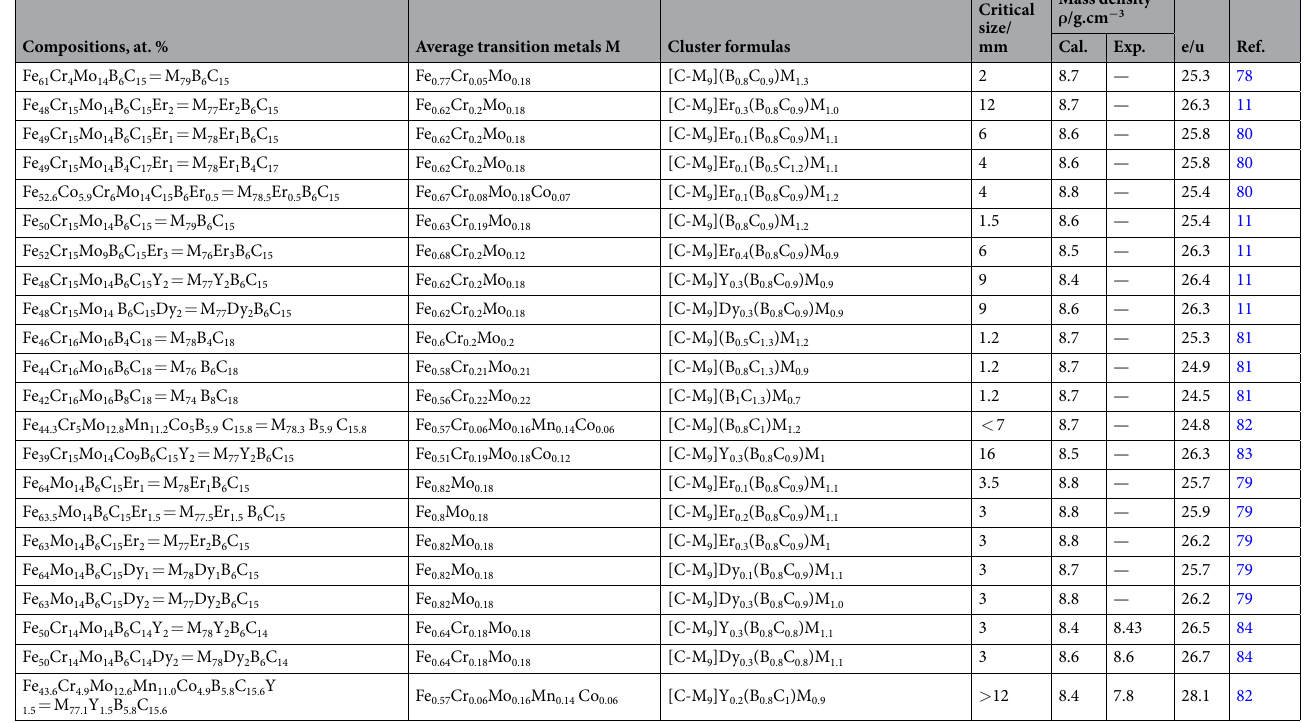
Table 1. Fe-metalloid-based bulk metallic glass compositions and their interpretation using the binary cluster formulas [B-B2Fe8]Fe1 (Z = 12, r1 = 0.2170 nm), [P-Fe9]P2Fe (Z = 13, r1 = 0.2337 nm), and [C-Fe9]C2Fe (Z = 13, r1 = 0.2184 nm). The critical diameter sizes for fully glassy ingots, estimated and measured densities, and e/u’s are also shown. Calculated mass densities are used only when experimental densities are not